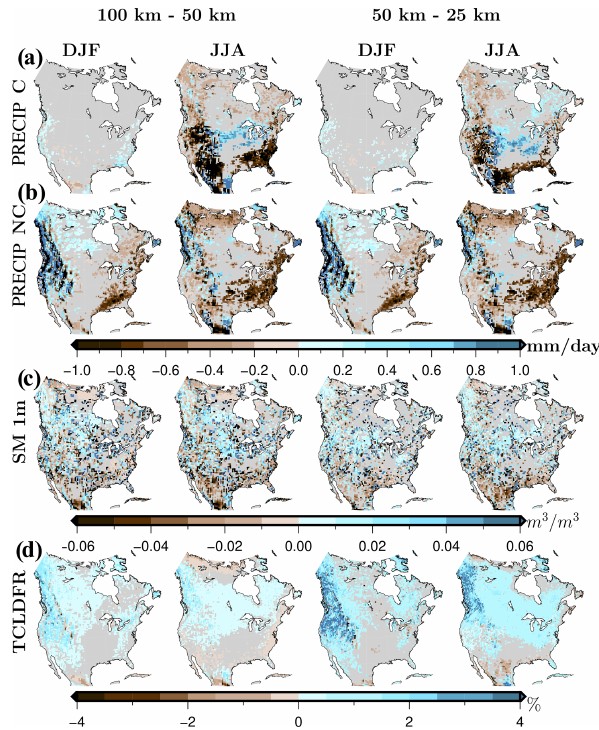
Figure 8. Seasonal mean difference in near-surface humid condi- tions between the 100 and 50km simulations (left) and between the 50 and 25km simulations (right). All outputs are from the NOAH- MP-DV simulations for the period 1980–2013. Grid cells with a non-significant change at the 5% significance level are masked in grey. All outputs from the 25, 50 and 100km simulations were mapped to a common grid (CRU grid) using the nearest model grid